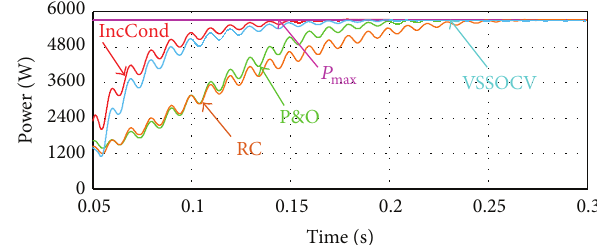
Figure 11: Power extracted from PV panels during the start-up with different MPPT techniques.